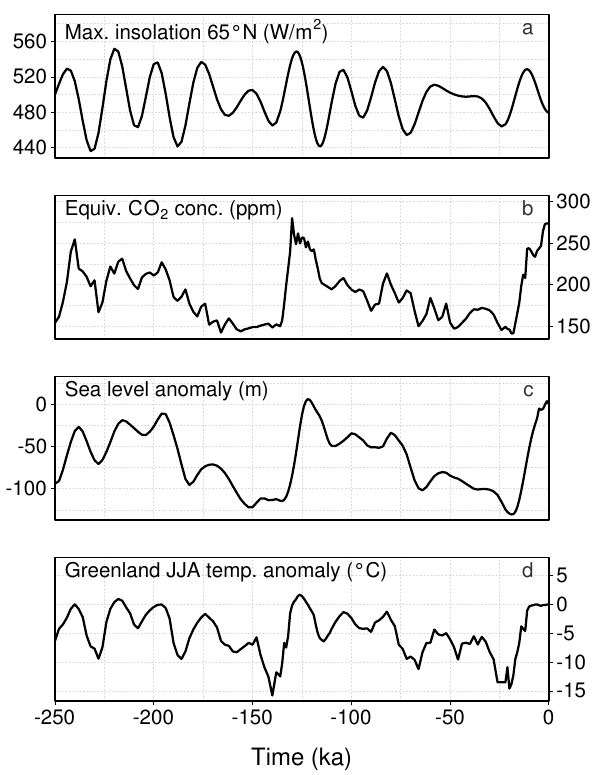
Fig. 1. Examples of forcing used for simulations of the last two glacial cycles: (a) maximum solar insolation at 65 ◦ N; (b) equiv- alent CO 2 concentration; (c) global sea level anomaly from SPECMAP; (d) Summer (June-July-August averaged) temperature anomaly prescribed at the boundaries of